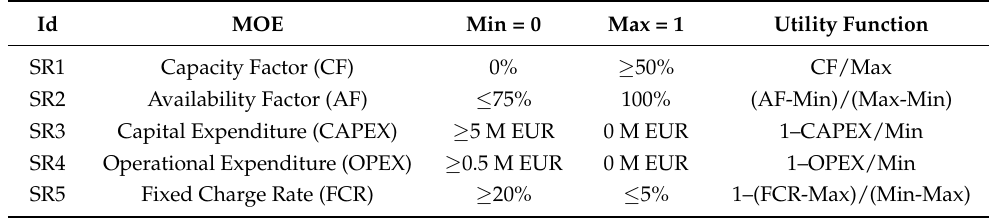
Table 10. Stakeholder Requirements and Utility.